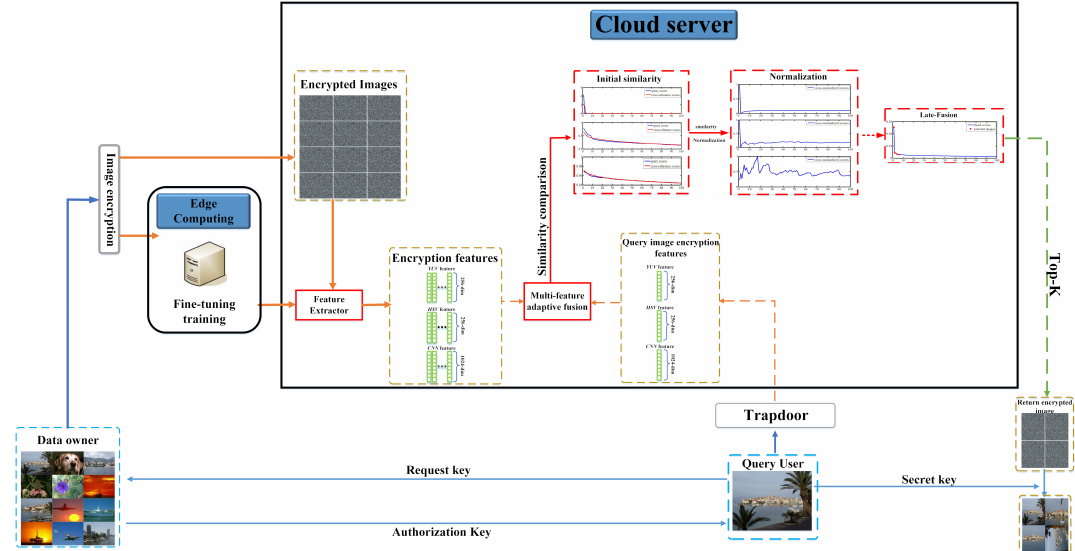
Figure 1. The system framework of our